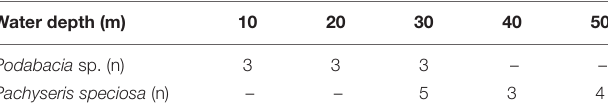
TABLE 1 | Distribution and number of samples used to assess diazotroph abundances associated with the tissues of two species of reef-building corals along a water depth gradient in the central Red